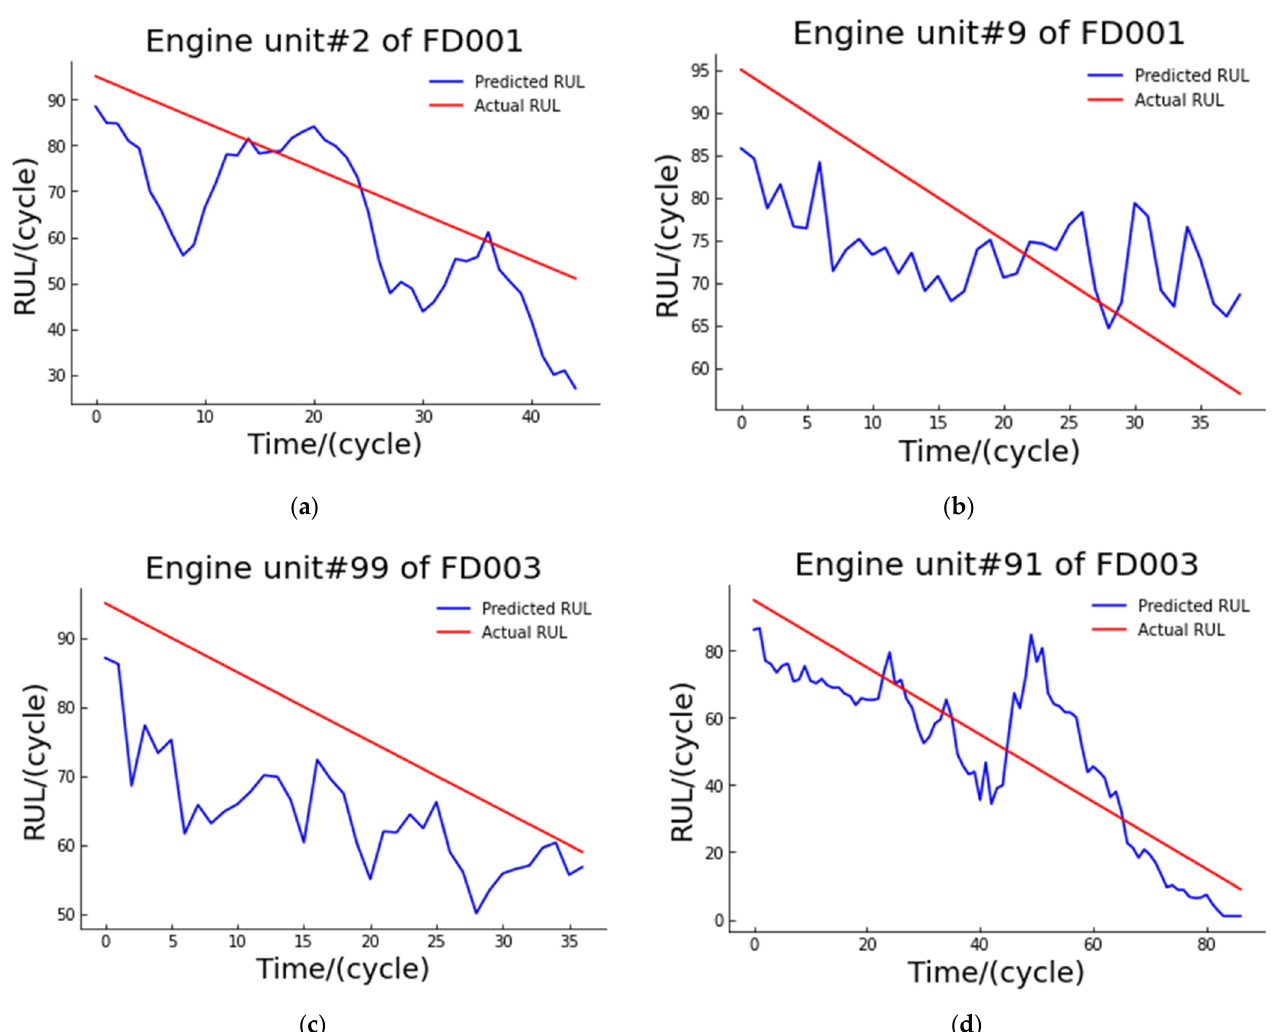
Figure 6. ( a , b ) The actual degradation curve and predicted degradation curve of two engines from FD001; ( c , d ) the actual degradation curve and predicted degradation curve of two engines from FD003.